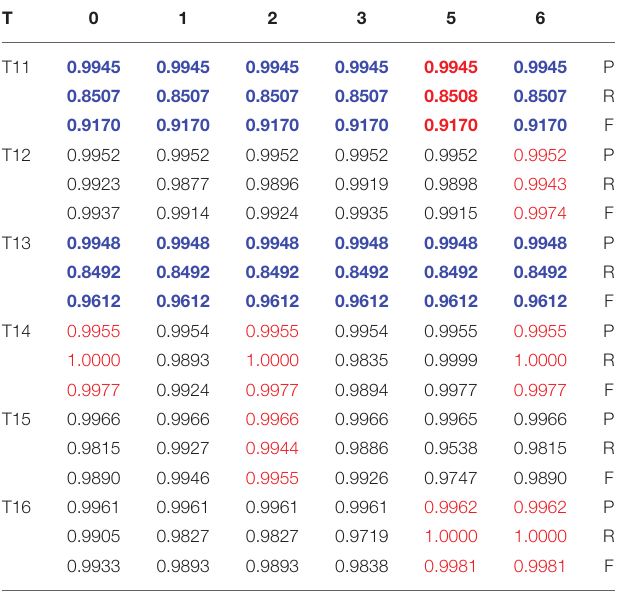
TABLE 6 | Image of group 3 within range of T is from − 1 to − 6.